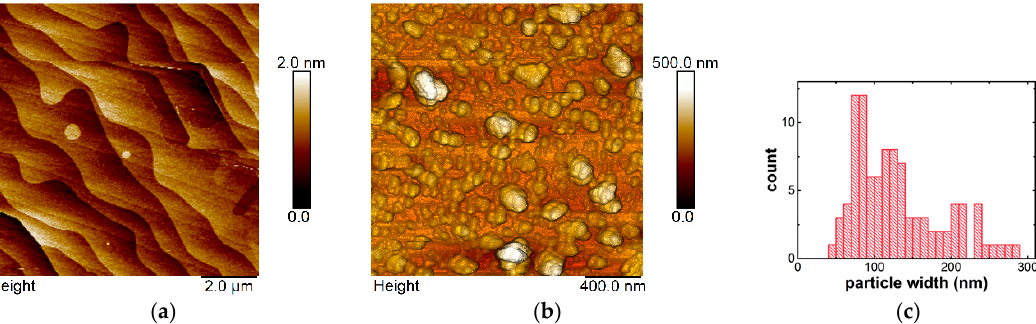
Figure 1. Atomic Force Microscopy (AFM) image of the graphene sensor surface before ( a ) and after ( b ) decoration with Fe 3 O 4 NPs, and ( c ) the particle width distribution.